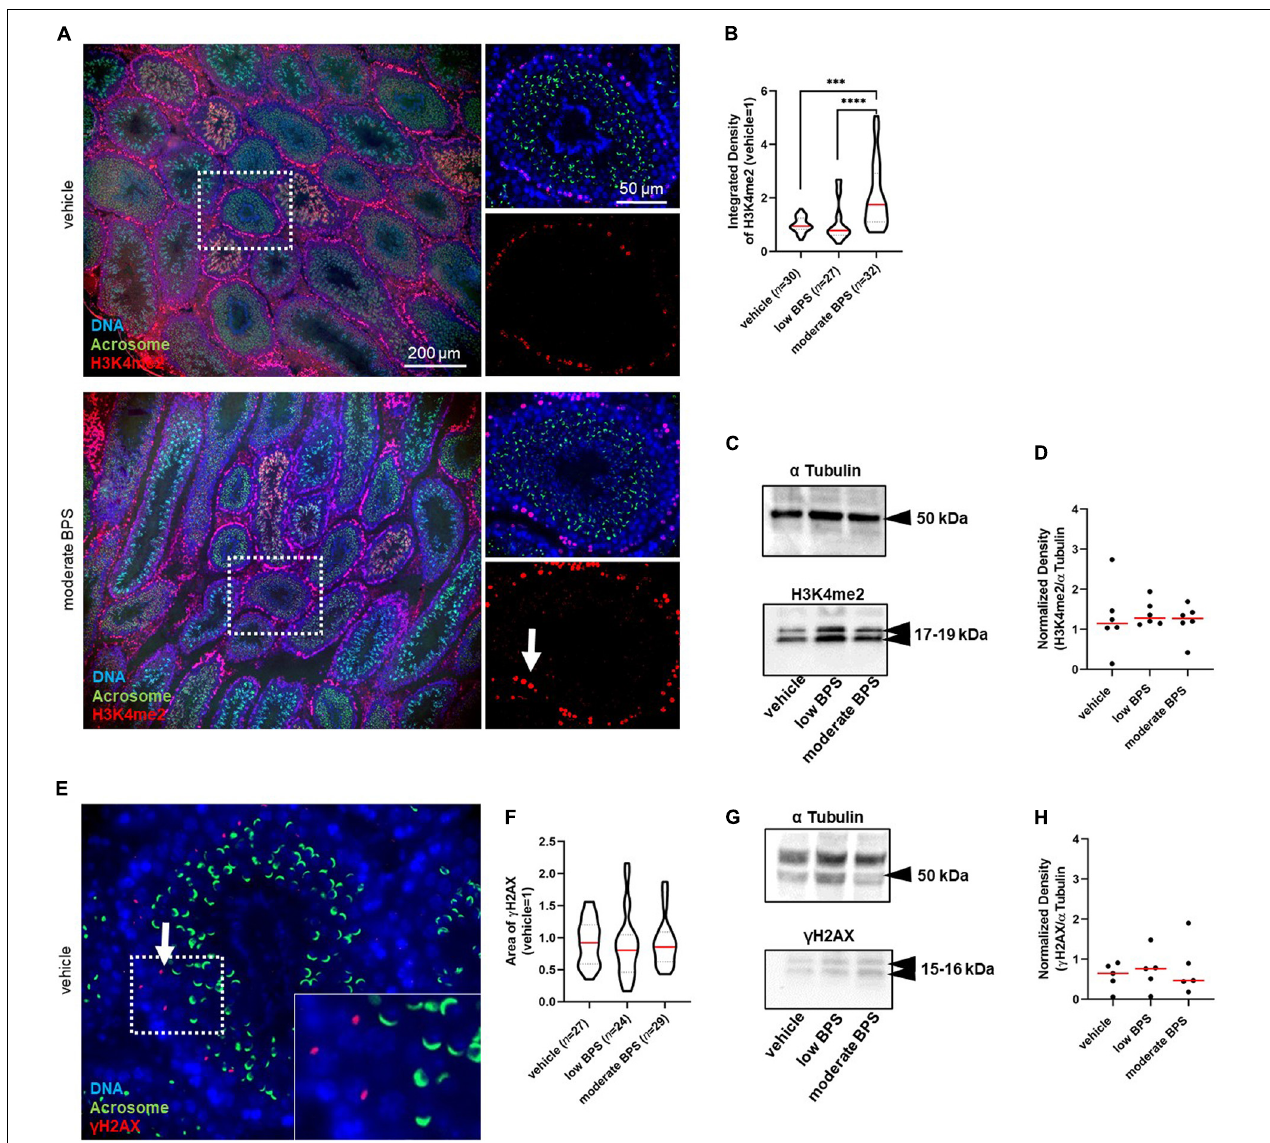
FIGURE 2 | Epigenetic quality of germ cells in the testicular tissue of adult males exposed to bisphenol during the nursing period. (A) Representative microphotographs of dimethylation of lysine (K4) on histone H3 (H3K4me2) in seminiferous tubules (magnification 10 × and 60 × ). The arrow indicates H3K4me2 in the seminiferous tubule. (B) Quantification of the intensity of the H3K4me2 expression in seminiferous tubules at stage VII–VIII of spermatogenesis marked by red fluorescence in control, low bisphenol S (BPS), and moderate BPS groups. The shape of the violin plot represents the distribution in each experimental group, and red lines represent median and dashed lines show quartiles. Numbers of analyzed seminiferous tubules belonging to three individual males are indicated in brackets. (C) Dimethylated testicular H3 on lysine K4 (H3K4me2). (D) Density of H3K4me2 in testicular tissue; band signals were normalized to α tubulin. Dots represent individual males; red lines show the median. (E) Representative microphotographs of phosphorylation of histone H2 ( γ H2AX) expression in seminiferous tubules. The arrow indicates γ H2AX in the seminiferous tubule. (F) Area of γ H2AX expression in seminiferous tubules at stage VII–VIII of spermatogenesis in control, low BPS, and moderate BPS groups. The shape of the violin plot represents the distribution in each experimental group, red lines represent median, and dashed lines show quartiles. Numbers of analyzed seminiferous tubules belonging to three individual males are indicated in brackets. (G) Phosphorylated testicular H2AX ( γ H2AX). (H) Density of γ H2AX in testicular tissue; band signals were normalized to α tubulin. Dots represent individual males; red lines show the median. The difference was tested using the Wilcoxon matched-pairs signed rank test. Asterisks indicate statistical differences ( ∗∗∗ P < 0.001, ∗∗∗∗ P < 0.0001). BPS: bisphenol S.